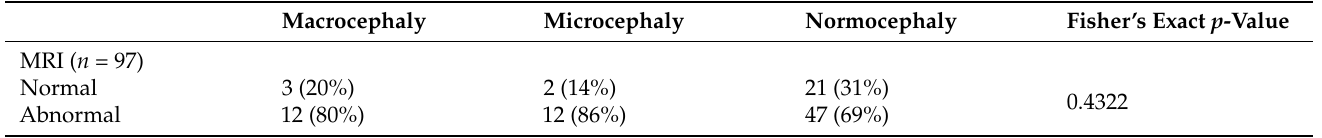
Table 4. Differences in 22q13 deletions and MRI findings by head size.